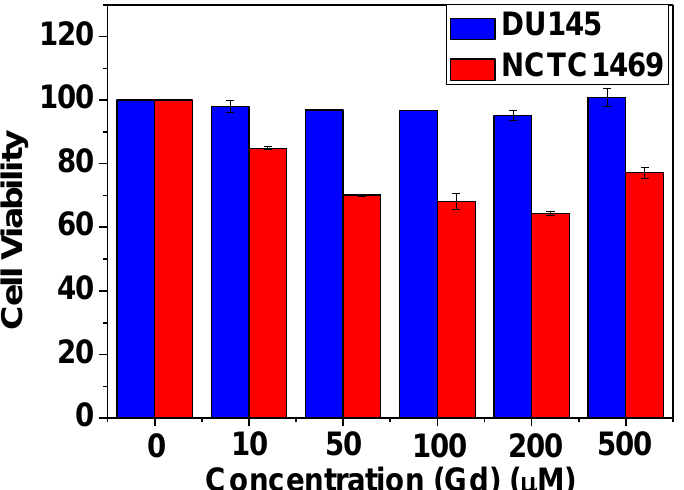
Figure 6. In vitro cell viabilities of PASA-coated Gd 2 O 3 nanoparticles in DU145 and NCTC1469 cells up to 500 μM Gd.